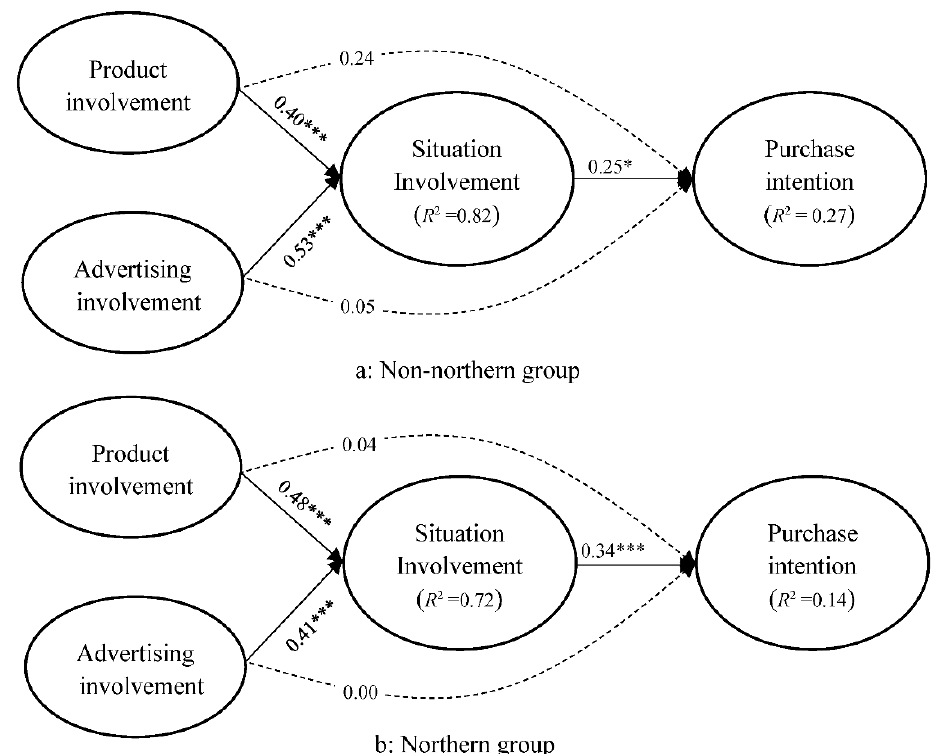
Figure 3. Moderation model for purchase intention in the nonnorthern region (( a ), n = 662) and northern region groups (( b ), n = 384) * p < 0.05, *** p < 0.001.